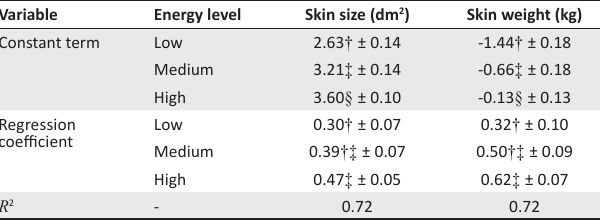
TABLE 5: Allometric equations relating the natural logarithm of the skin characteristics to the natural logarithm of the empty body protein weight (kg) for each energy level.